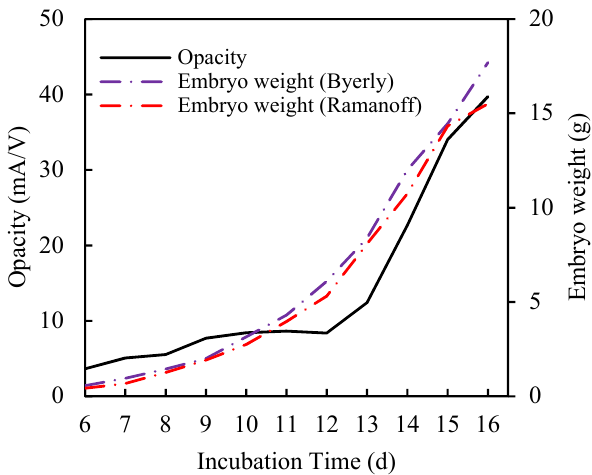
Figure 2. Changes in opacity and embryo weight during incubation. There were almost similar trends in near-infrared (NIR) opacity value and embryo weight change during incubation.